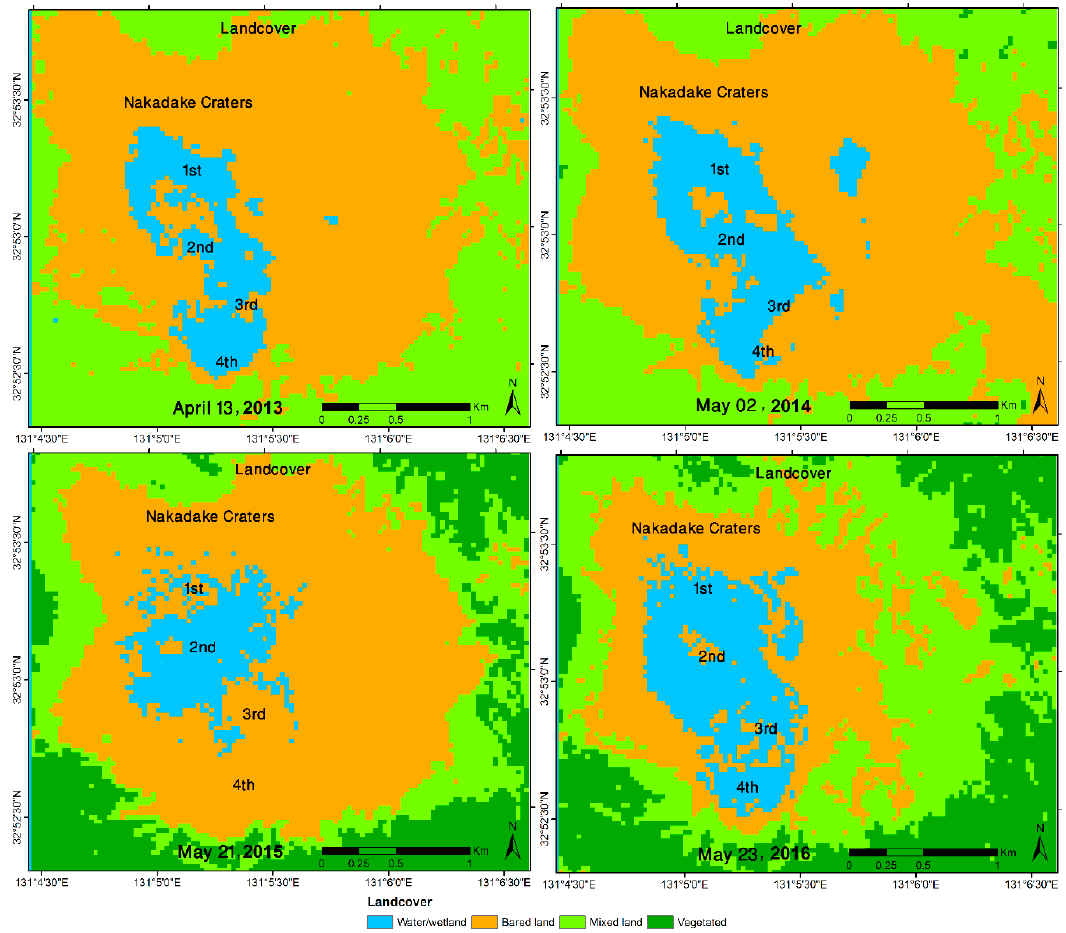
Figure 3. The land cover maps of the study area from 2013 to 2016, derived from the NDVI values for healthy vegetated area, mixed land, bare land, and water or wetlands.